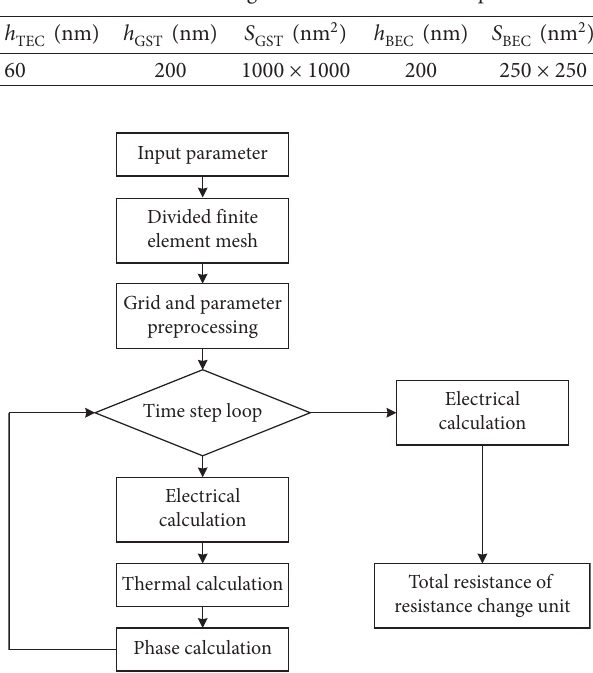
Figure 3: Resistance change unit simulation calculation flow chart.